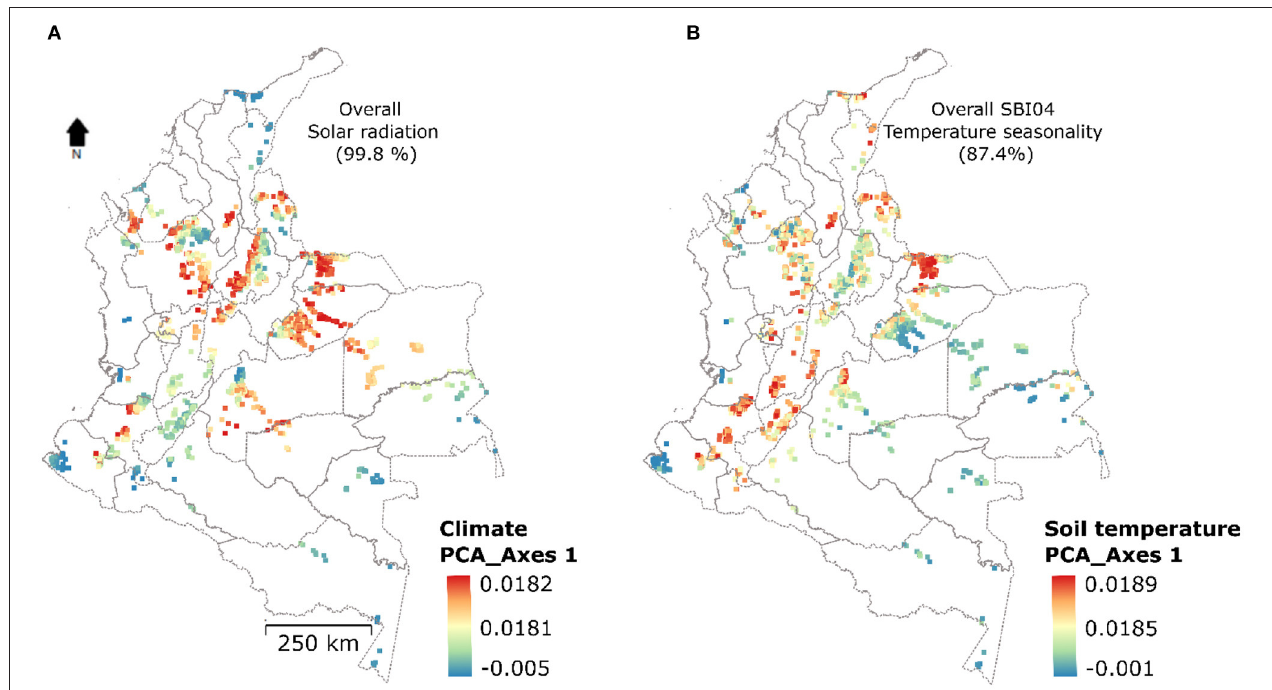
FIGURE 2 | Geospatial analysis of climate (A) and soil temperature (B) variables for the regions of cacao in Colombia based on a PCA for Axes 1.